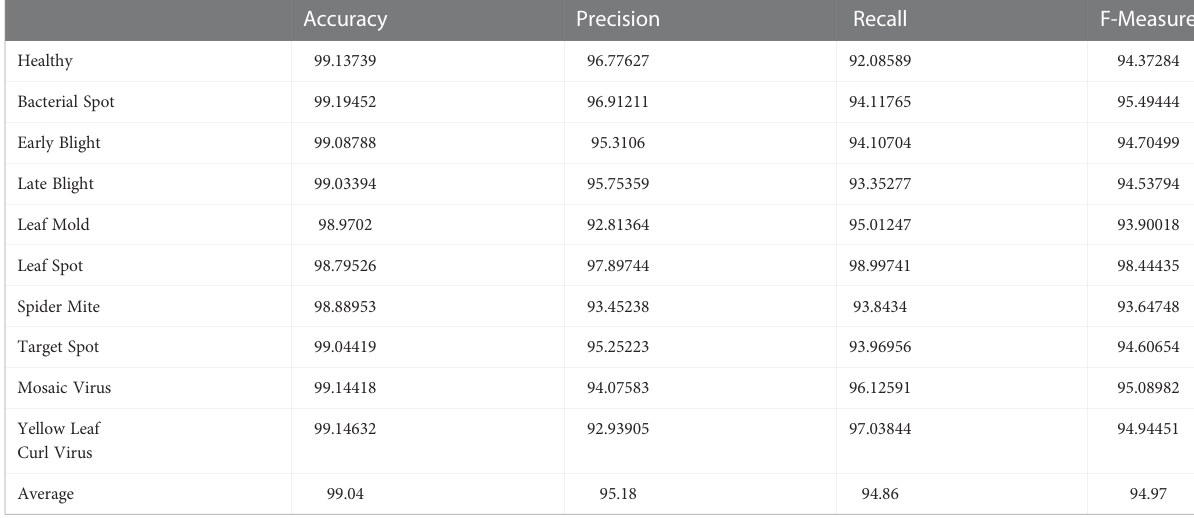
TABLE 10 Detail Performance by class for Tomato disease